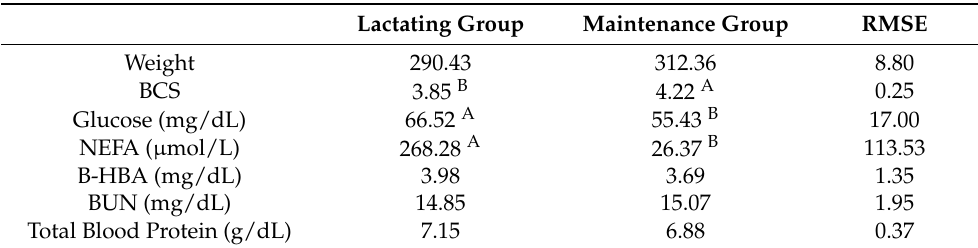
Table 4. Weight, BCS and blood metabolic parameters of jennies in lactation and maintenance fed the same diet (Diet 2). Lactating Group Maintenance Group RMSE Weight